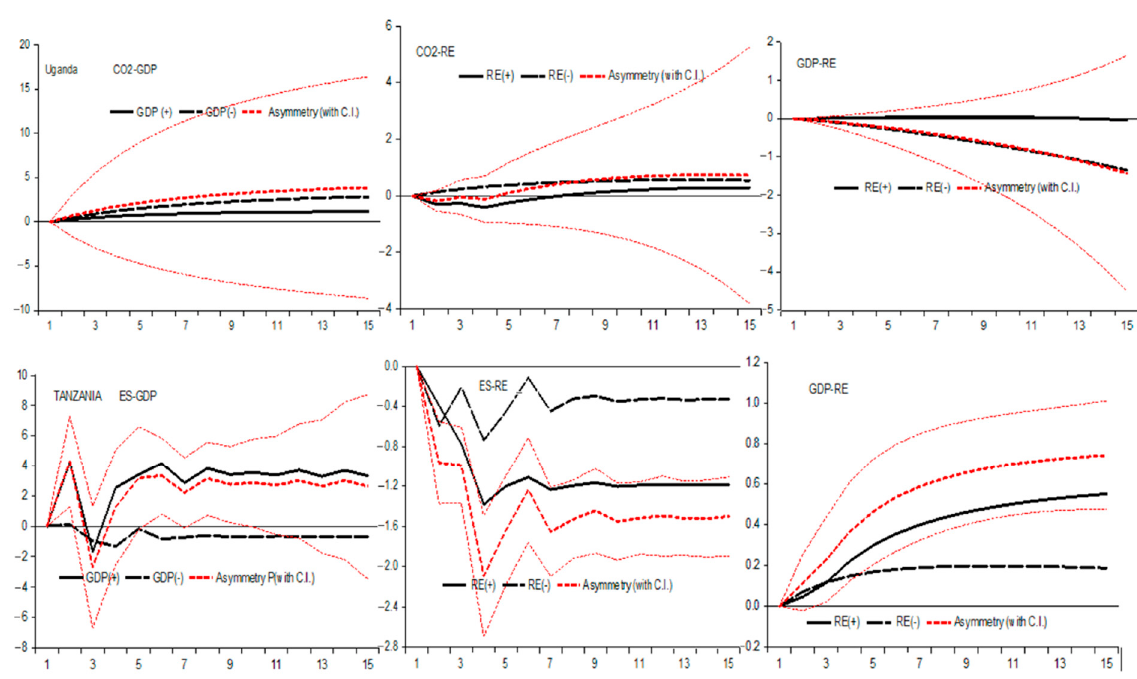
Figure 2. Dynamic multiplier plots of the nonlinear asymmetric and symmetric relationship between CO 2 emissions and GDP, CO 2 emissions and renewable energy, and GDP and renewable energy in Rwanda, Ethiopia, and Burundi.